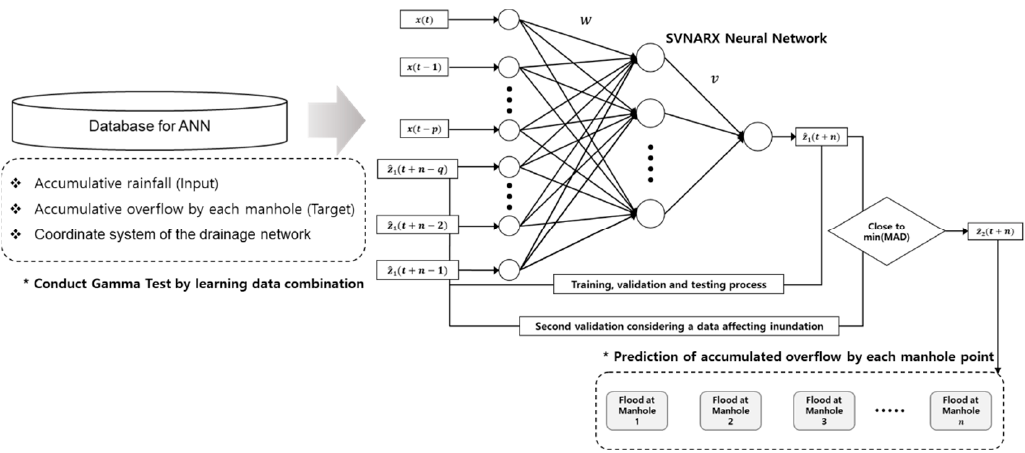
Figure 3. Prediction process of SVNARX (The Second Verification Algorithm of Nonlinear Auto-Regressive with eXogenous inputs).